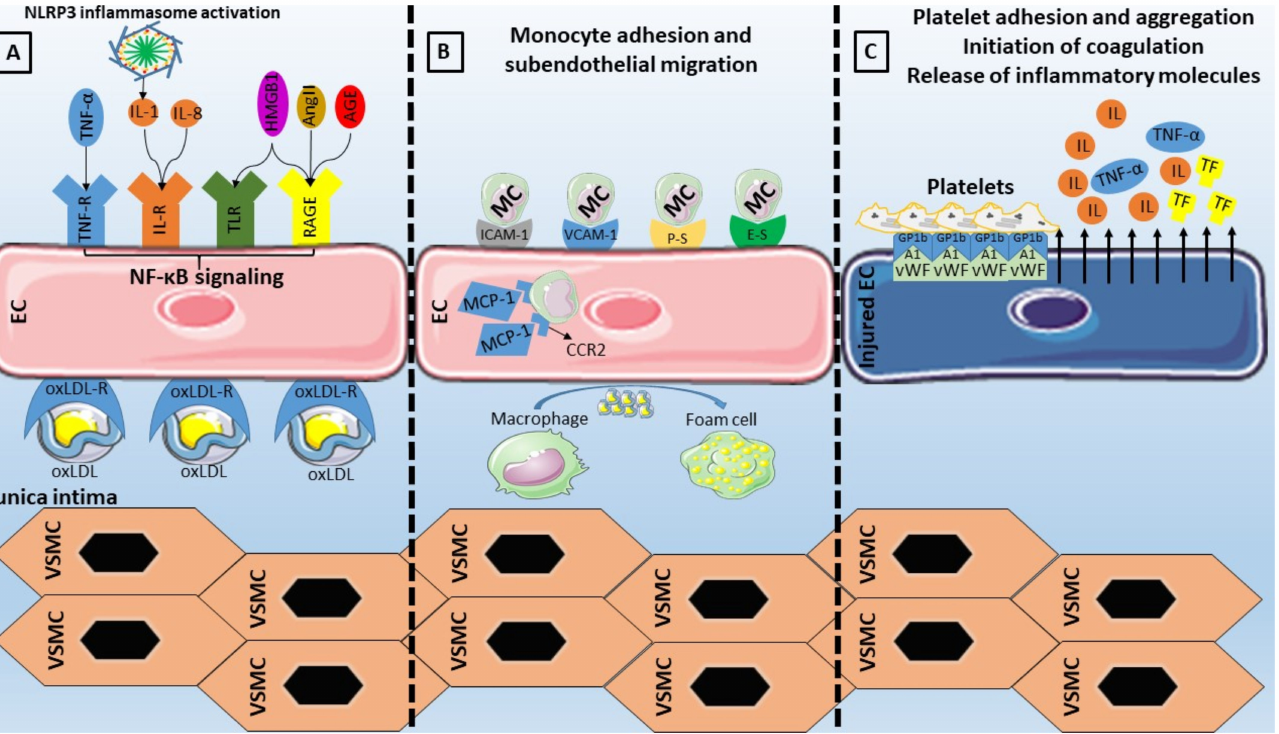
Figure 1. Inflammatory activation of endothelial cells (ECs). ( A ) Stimulation of EC receptors by damage-associated molecular patterns (High mobility group box 1 (HMGB1)), inflammatory cytokines (tumor necrosis factor (TNF)- α , interleukins (ILs)), oxidized low-density lipoproteins (oxLDL), advanced glycation end products (AGEs), and angiotensin (Ang)-II promotes nuclear factor- κ B (NF- κ B) signaling which results in ( B ) upregulation of adhesion molecules (vascular cell adhesion molecule (VCAM)-1, intercellular adhesion molecule (ICAM)-1, E-Selectin (E-S), P-Selectin (P-S)) with subsequent monocyte (MC) adhesion and subendothelial transmigration with the aid of monocyte chemoattractant protein (MCP)-1 and its receptor C-C chemokine receptor type 2 (CCR2). Monocytes proceed to differentiate into macrophages that phagocytose oxLDL to become foam cells. ( C ) Injured endothelial cells release inflammatory mediators and tissue factor (TF) further promoting inflammation and coagulation, while the release of von-Willebrand factor (vWF) from the Weibel-Palade bodies results in platelet adhesion and aggregation following the binding with platelet glycoprotein (GP)1b. NLRP3: NLR family pyrin domain containing 3, TLR: toll-like receptor, RAGE: receptor of advanced glycation end products, VSMC: vascular smooth muscle